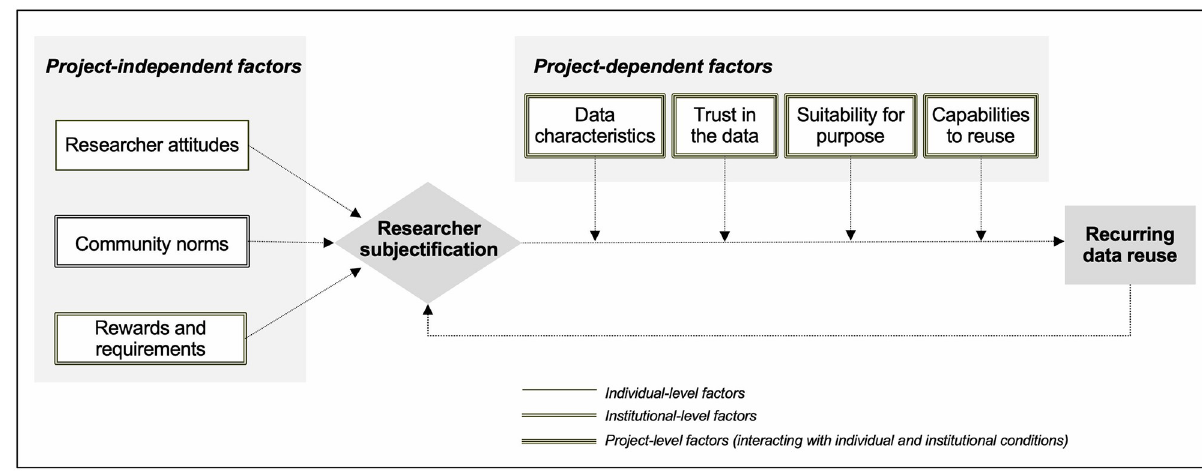
Fig 1. A model of recurring data reuse behavior.